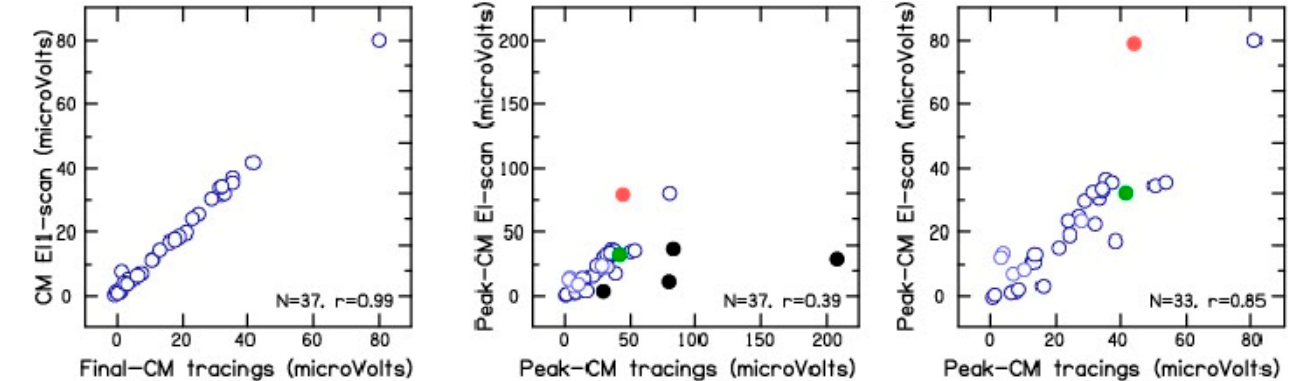
Figure 5. Left panel shows the correlation between the CM amplitude (µV) measured on the most apical electrode at the end of electrode placement and during electrode scan. Middle panel shows the peak CM amplitude (µV) measured during electrode placement and electrode scan. Black filled circles show correlated decreases in CM for the four test frequencies on electrode 11 for patient CI8. Green (CI5, 507 Hz) and red (CI10, 725 Hz) filled circles show phase reversal. Right panel shows the peak CM amplitude (µV) measured during electrode placement and electrode scan, but without the data for patient CI8. N refers to the number of test frequencies shown in each panel.